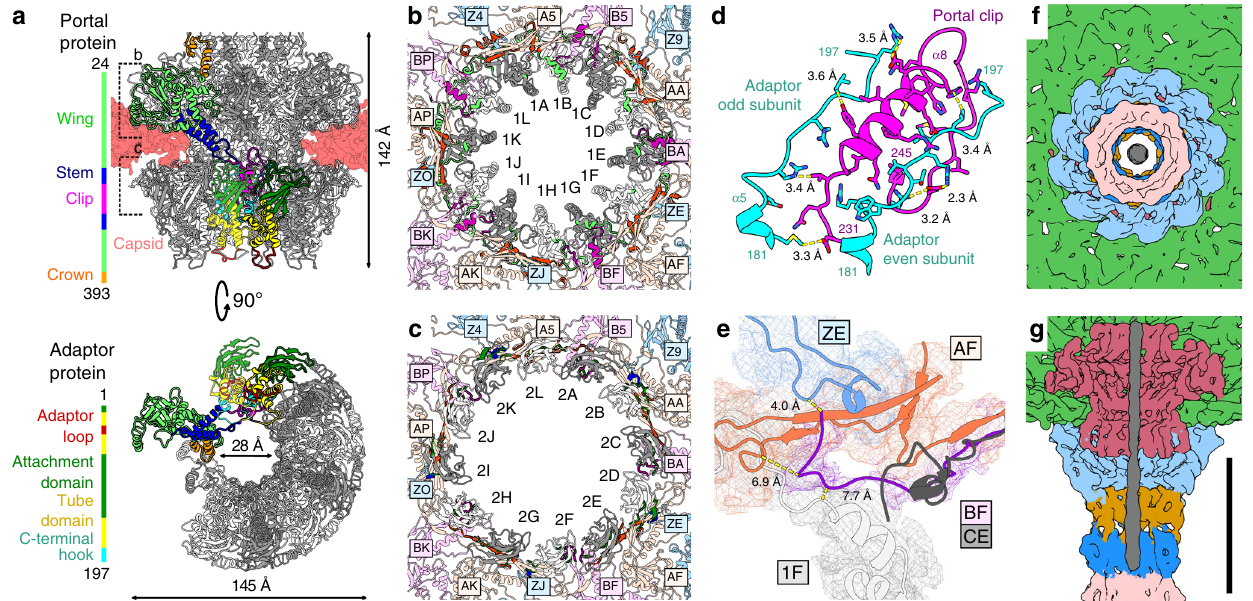
Fig. 3 Portal and adaptor complexes. a Side and bottom views of portal and adaptor complexes with one subunit of the portal protein and two subunits of the adaptor protein highlighted in different colors. One of the adaptor proteins is highlighted with a black outline. Five subunits of portal protein and four subunits of adaptor proteins were removed from the bottom view. The domains of the selected subunits are color-coded as indicated in the sequence diagrams on the left. Differences in the structures of adaptor loops (red) of neighboring adaptor proteins enable reduction of the tail symmetry from twelvefold to six-fold. b , c Interactions of wing domain of portal proteins ( b ) and attachment domain of adaptor proteins ( c ) with capsid. Alternating subunits of portal ( b ) and adaptor ( c ) complexes are shown in white and gray. Residues of portal and adaptor proteins that interact with the capsid are highlighted in bright colors according to which domain they belong to. The portal and adaptor complexes interact with capsid proteins in three different orientations, which are distinguished by magenta, orange, and blue. Residues of capsid proteins that bind to portal and adaptor proteins are highlighted in bright colors. Subunit are labelled according to PDB 6TBA. d Interactions between the clip domain of the portal protein (magenta) and C-terminal hooks of adaptor proteins (cyan). Sidechains of interacting residues are shown in stick representations. e Unique structure of the N-terminus of capsid protein subunit BF (magenta) interacting with the portal complex (light gray). Capsid protein CE (gray), which does not interact with the portal complex, was superimposed onto the BF subunit. The N-terminus of the CE subunit clashes with the surrounding structures. f , g The end of the double-stranded DNA positioned in the RcGTA neck does not bind to the surrounding proteins of the native RcGTA. f View of tail along its axis towards the center of the head. g View of neck region with front half removed. DNA is shown in gray, tail tube proteins in pink, tail terminator proteins in blue, stopper proteins in dark orange, adaptor proteins in cyan, portal proteins in purple, and capsid proteins in green. Scale bar 10